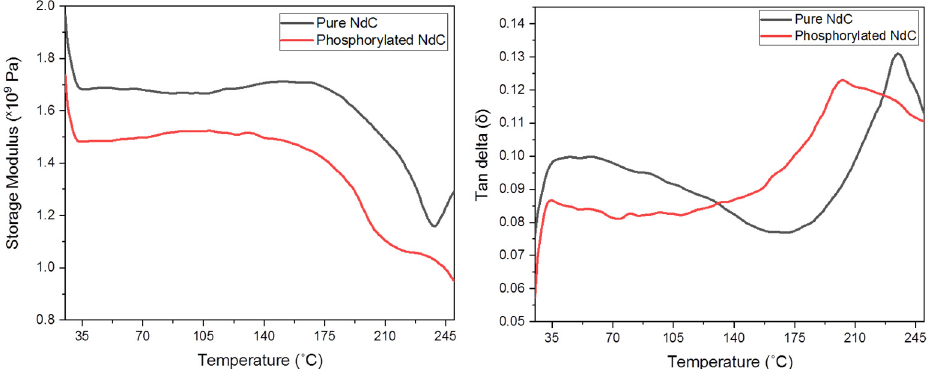
Figure 7. Tan δ and storage modulus of pure NdC and phosphorylated NdC20 membrane.